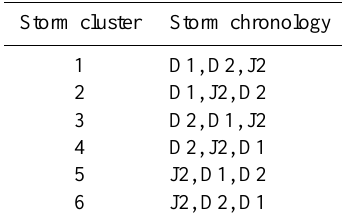
Table 1. Defined storm clusters using different storm wave chronologies of the three storm events (D1, D2 and J2).